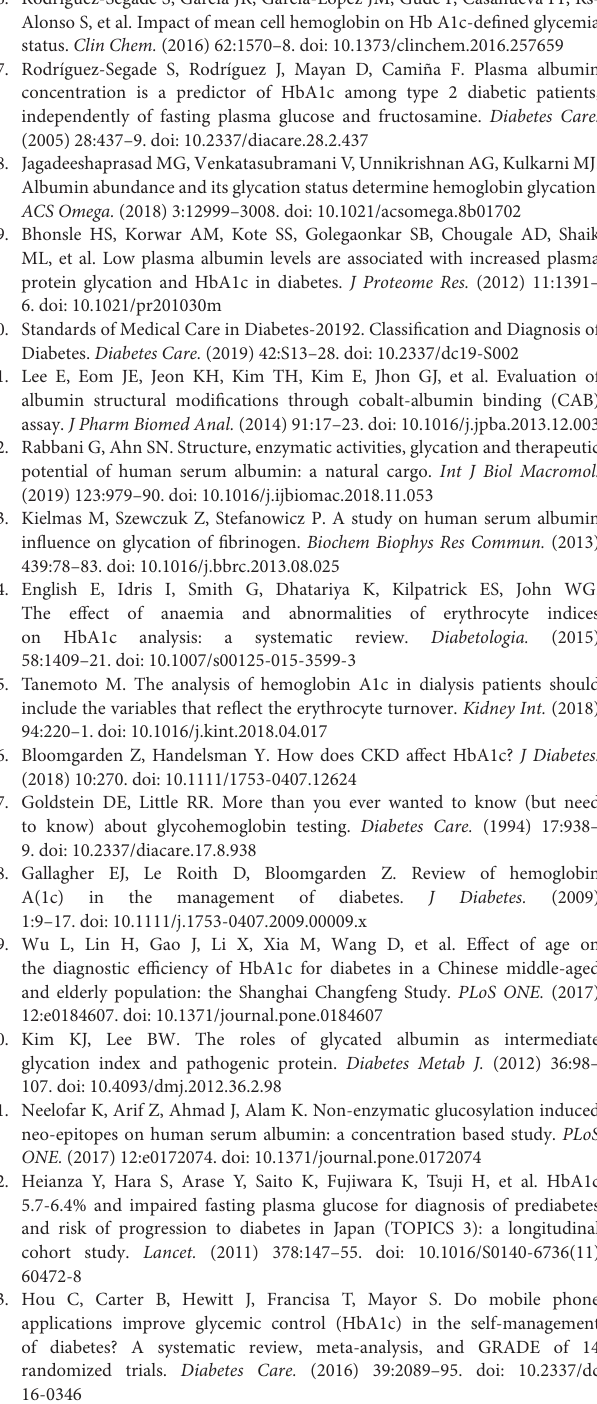
Supplementary Figure 2 | Quintiles of serum albumin levels and HbA1c value. Quintiles of serum albumin levels and HbA1c in total participants. Supplementary Figure 3 | Quintiles of serum albumin levels and FPG-defined glycemia status.